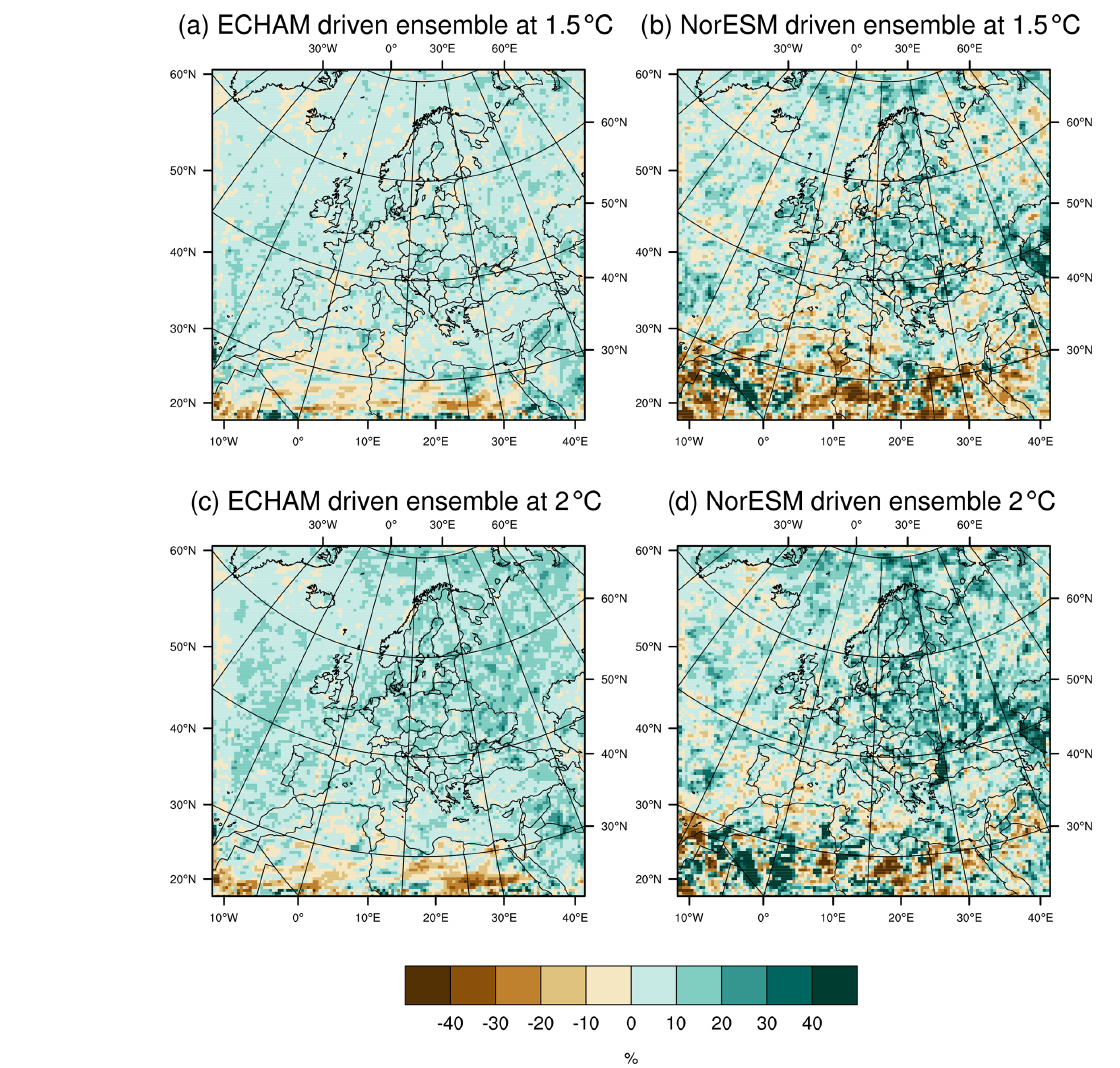
Figure 5. Relative difference of RI50yr (in percent) between current and the 1.5 ◦ C period and (a, b) the 2.0 ◦ C period (c, d) for ECHAM6 with 100 members (a, c) and the NorESM with 25 members (b, d) driven REMO simulations. Table 1. Mann–Whitney U test p values for distributions of consecutive dry days (CDDs) for the ECHAM6- and NorESM-driven ensembles for different PRUDENCE regions (for locations see Fig. 1). Bold values indicate statistically significant